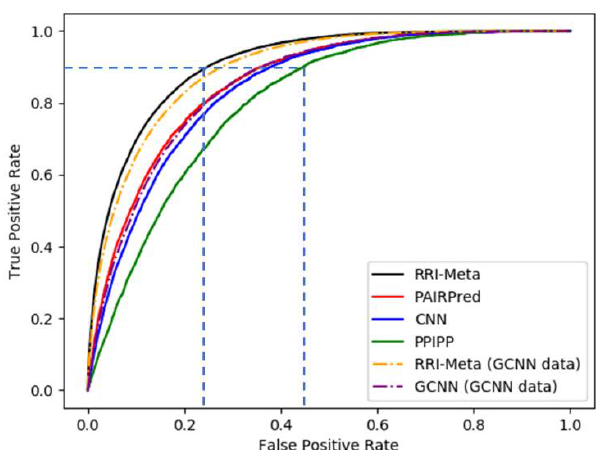
Figure 2. The ROC curves for RRI predictors based on LOOCV.